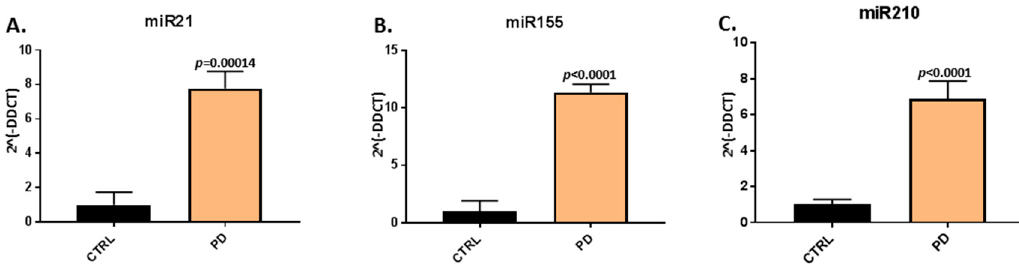
Figure 3. MicroRNA analysis of inflammatory and hypoxia associated microRNAs in circulating plasma-EVs of pre-motor PD and sham animals. ( A ) Significantly increased relative expression of the inflammatory miR21 was observed in plasma-EVs of the pre-motor PD rats, compared with shams. ( B ) Significantly increased relative expression of the inflammatory miR155 was observed in plasma-EVs of pre-motor PD rats, compared with shams. ( C ) The relative expression of the hypoxia related miR210 was significantly increased in plasma-EVs of pre-motor PD rats, compared with those of sham-treated animals. Results are represented as relative microRNA (miR) expression compared to the internal control miRs (2 Λ (-DDCT)); exact p -values are indicated, error bars show SD ( n = 3 biological and three technical replicates for all; ctrl = sham; PD = pre-motor PD models).